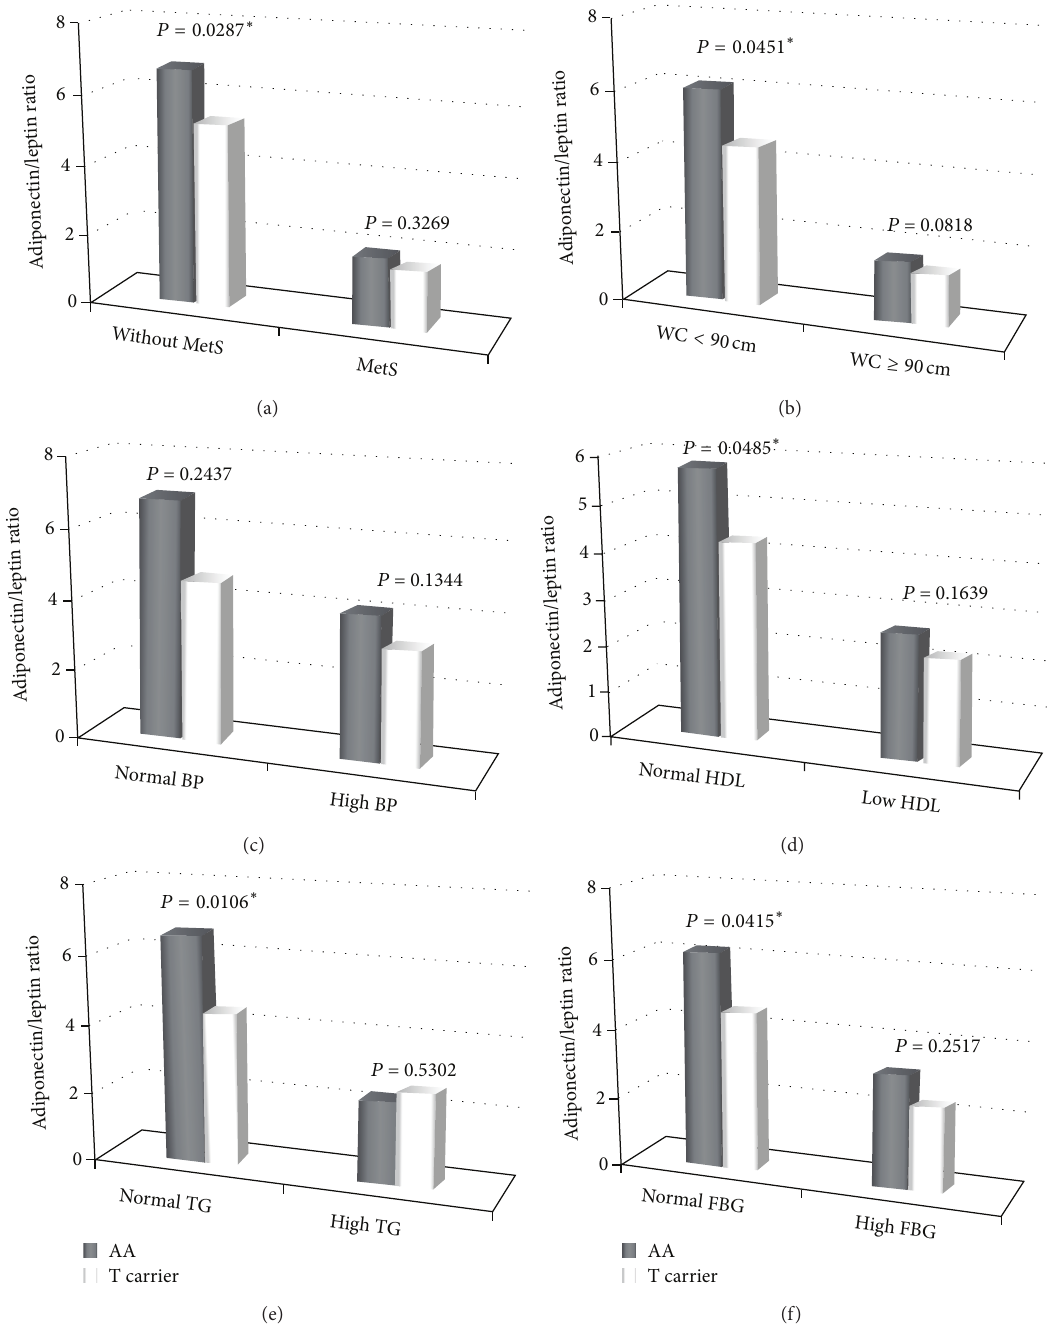
Figure 3: Associations between the CYP27A1 rs4674344 SNP and each component of the metabolic syndrome (MetS) for the adiponectin/leptin (A/L) ratio. The A/L ratio was only significant as the condition did not meet all individual MetS criteria except for the BP component after adjusting for age, BMI, smoking, alcohol drinking, betel nut chewing, CAD, total cholesterol, LDL, CHOL(T)/HDL, and the other 4 components, respectively, for the CYP27A1 rs4674344 SNP. BMI: body mass index; BP: blood pressure; DM: diabetes mellitus; CHOL(T): total cholesterol; HDL: high density lipoprotein; TG: triglycerides. ∗ Significant difference ( 𝑃 < 0.05 ).